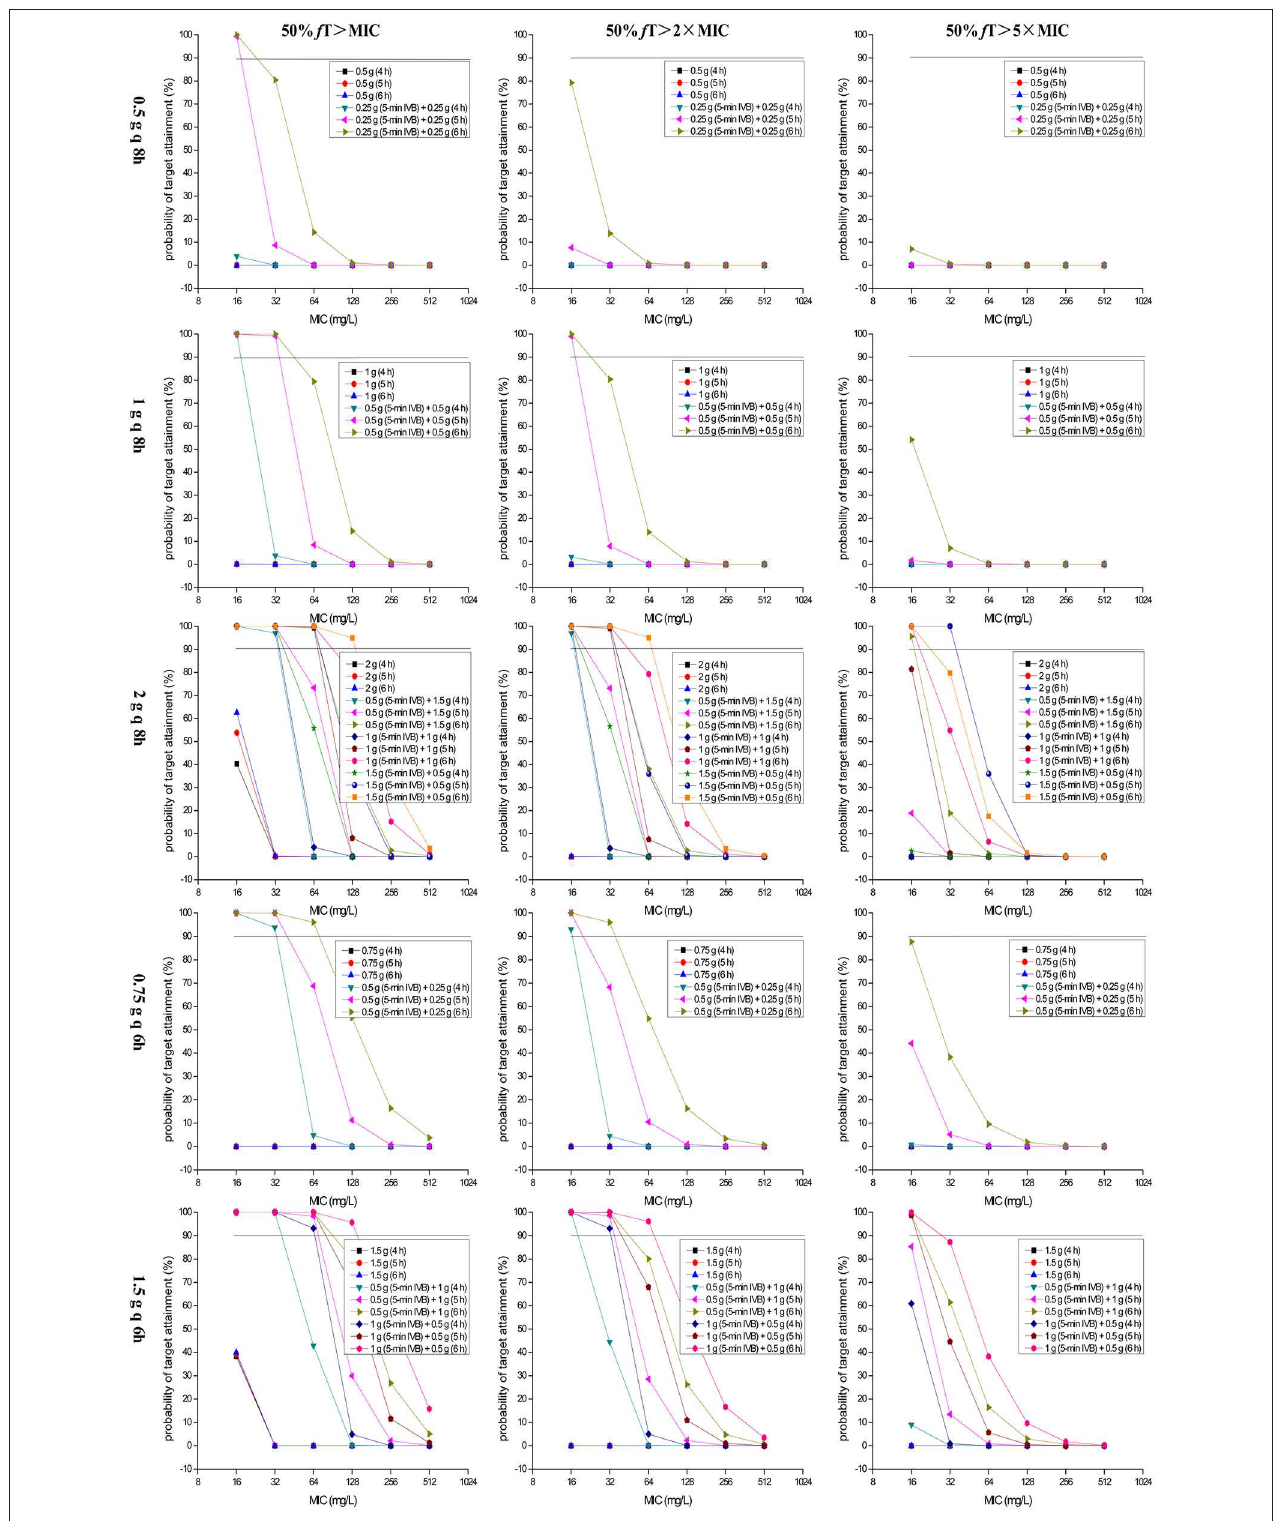
FIGURE 2 | PTAs of achieving 50% f T > MIC, 50% f T > 2 × MIC and 50% f T > 5 × MIC for meropenem with various dosage regimens simulated for MICs up to 512 mg/L. MIC, minimum inhibitory concentration; 50% f T > MIC, 50% of the dosing interval during which free drug concentrations remain above the MIC; 50% f T > 2 × MIC, 50% of the dosing interval during which free drug concentrations remain above the MIC by two-fold; 50% f T > 5 × MIC, 50% of the dosing interval during which free drug concentrations remain above the MIC by five-fold.